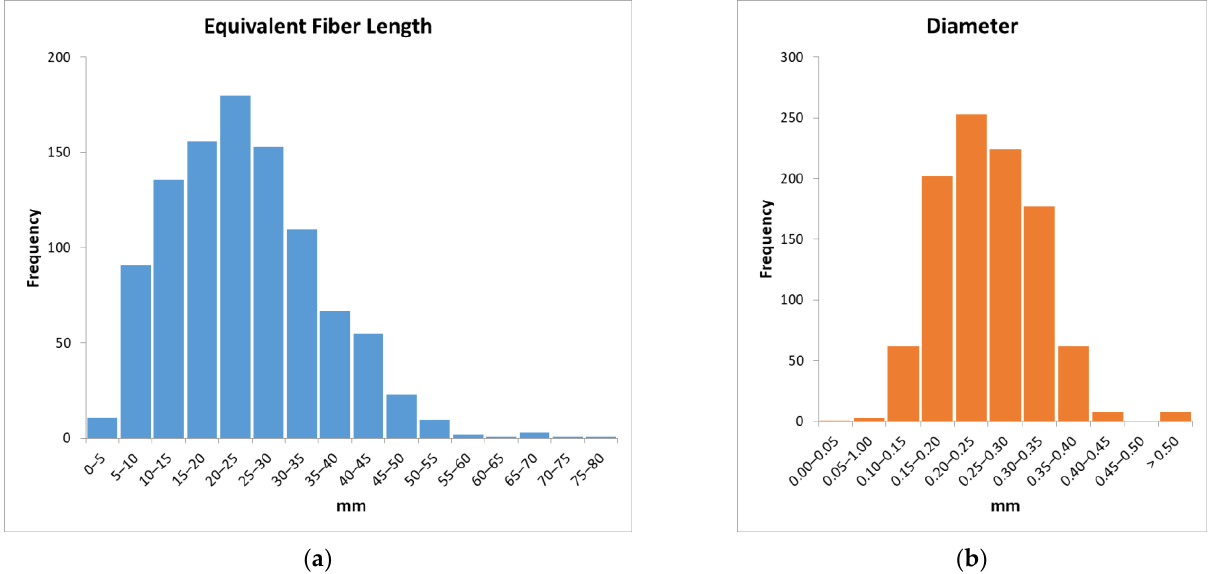
Figure 8. Histograms of geometrical characteristics: ( a ) Equivalent Fiber Length; ( b ) diameter.